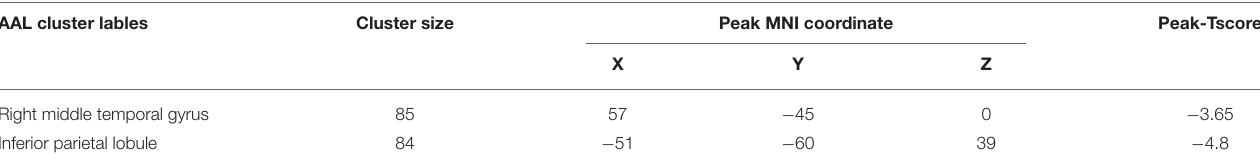
TABLE 3 | Regions showing significant differences in fALFF values between DYS and